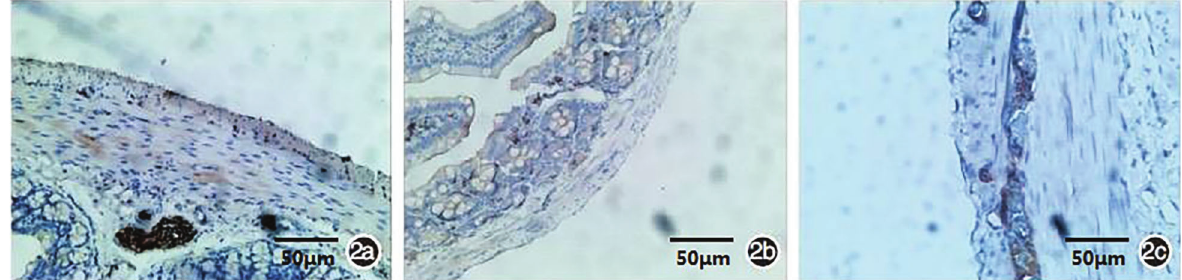
Figure 2. Immunohistochemical images of c-Kit protein in rat colon cells ( (cid:3) 200, bar: 50 m m). 2a , Slow transit constipation (STC) bisacodyl group; 2b, STC group; 2c, Control